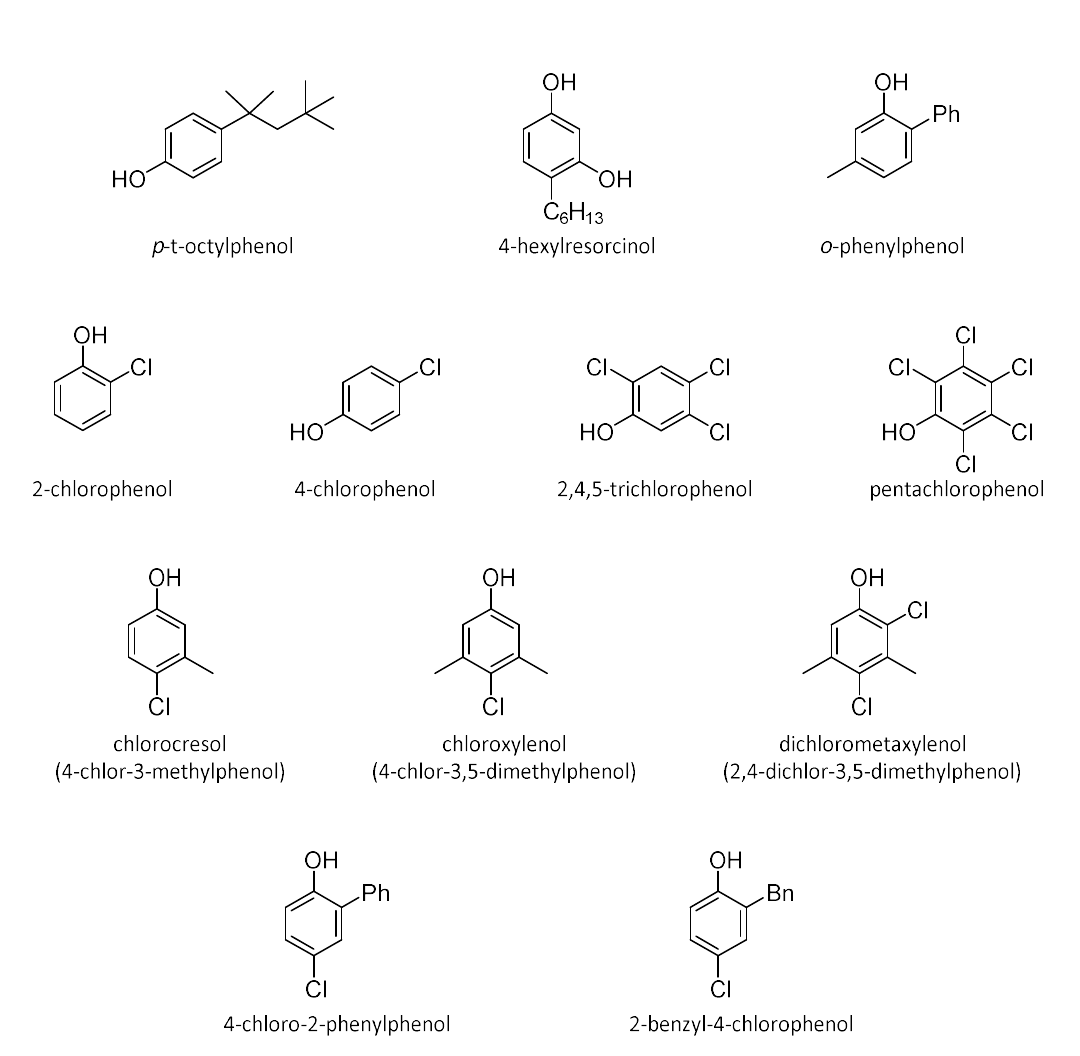
Figure 11. Several microbiocidal phenols.